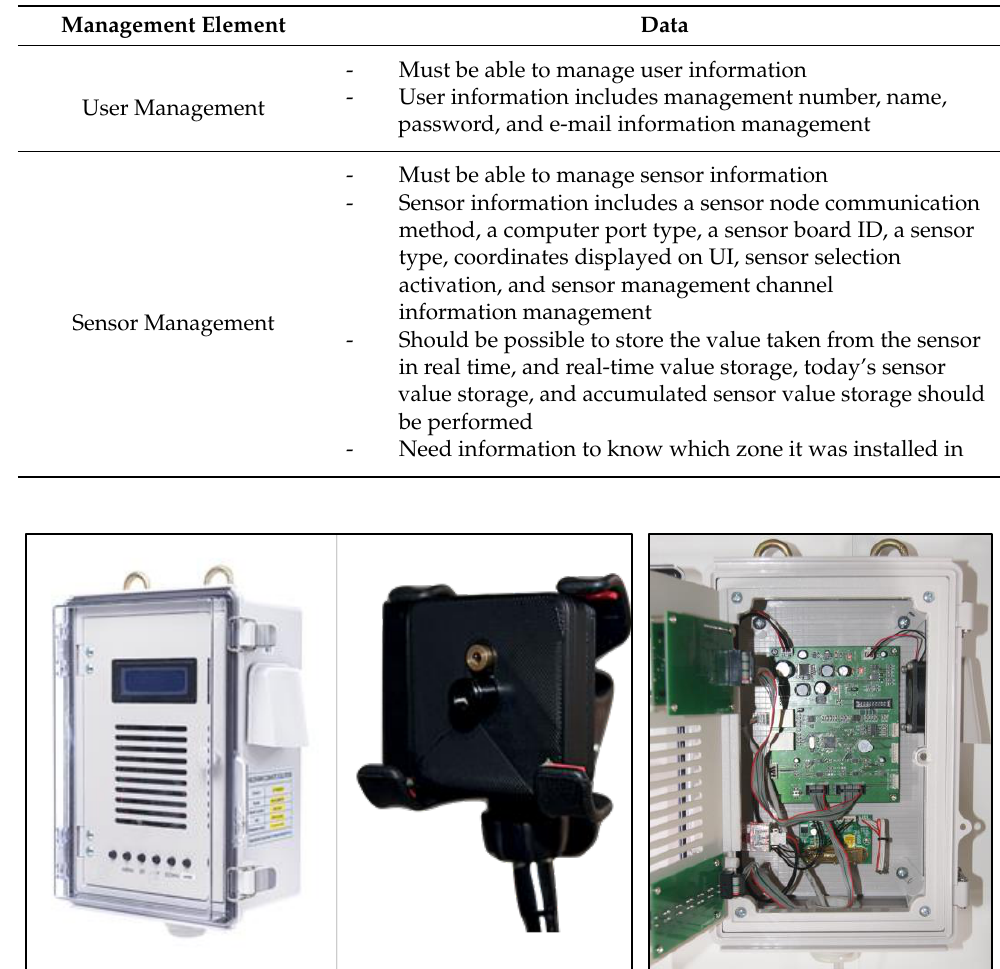
Table A1. Data requirement for analysis.